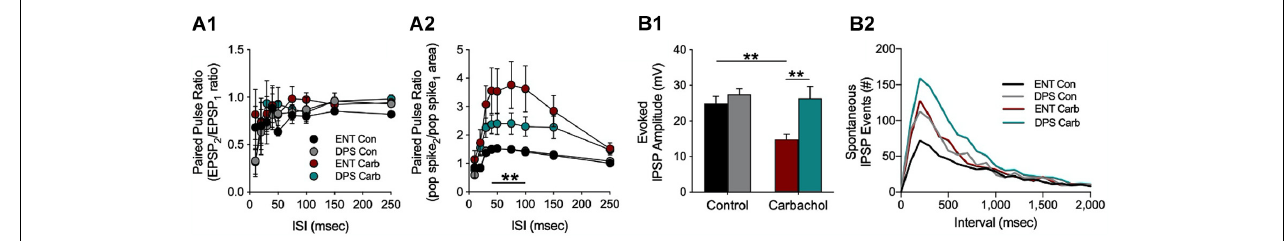
FIGURE 7 | Increased synaptic inhibition and reduced cholinergic responsiveness in the dentate gyrus of DPS hamsters. (A) Paired pulse ratios from granule cells in the dentate gyrus at different interstimulus intervals (ISI) during simultaneous recordings of (A1) field excitatory postsynaptic potentials (fEPSPs) and (A2) populations spikes (POP) under control (Con) or carbachol bath (Carb, 10 µ M) conditions. Note that we use area rather than amplitude to quantify the POP spike. This is because amplitude can be confounded both by the number of cells excited by the stimulus and by the synchrony of those cells whereas POP spike area is not. The carbachol-induced population spike increase was attenuated in cells from DPS hamsters compared to cells from ENT animals at ISIs from 40–100 Hz (** P < 0.01). (B1) Carbachol normally suppresses evoked inhibition as it did here in the control group (ENT, red); however carbachol had no effect on cells from DPS hamsters (green) where evoked inhibition remained high (** P < 0.001). (B2) The number of spontaneous IPSP events in cells from DPS hamsters was 2x that observed in cells from ENT animals under control conditions at intervals < 500 ms (KS test, P = 0.014). Carbachol increased spontaneous IPSPs by the same magnitude in both groups. Figure modified from McMartin et al. (2021).